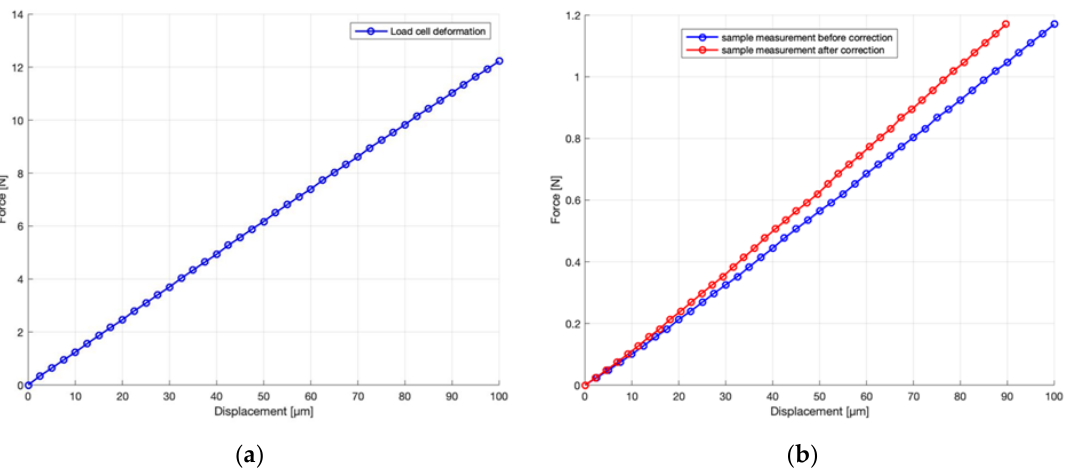
Figure 2. ( a ) Force–displacement curve of the load cell. ( b ) Typical measurement curve before and after correcting for load cell compliance.